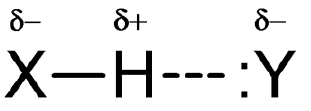
Figure 1. Isolated hydrogen bond.